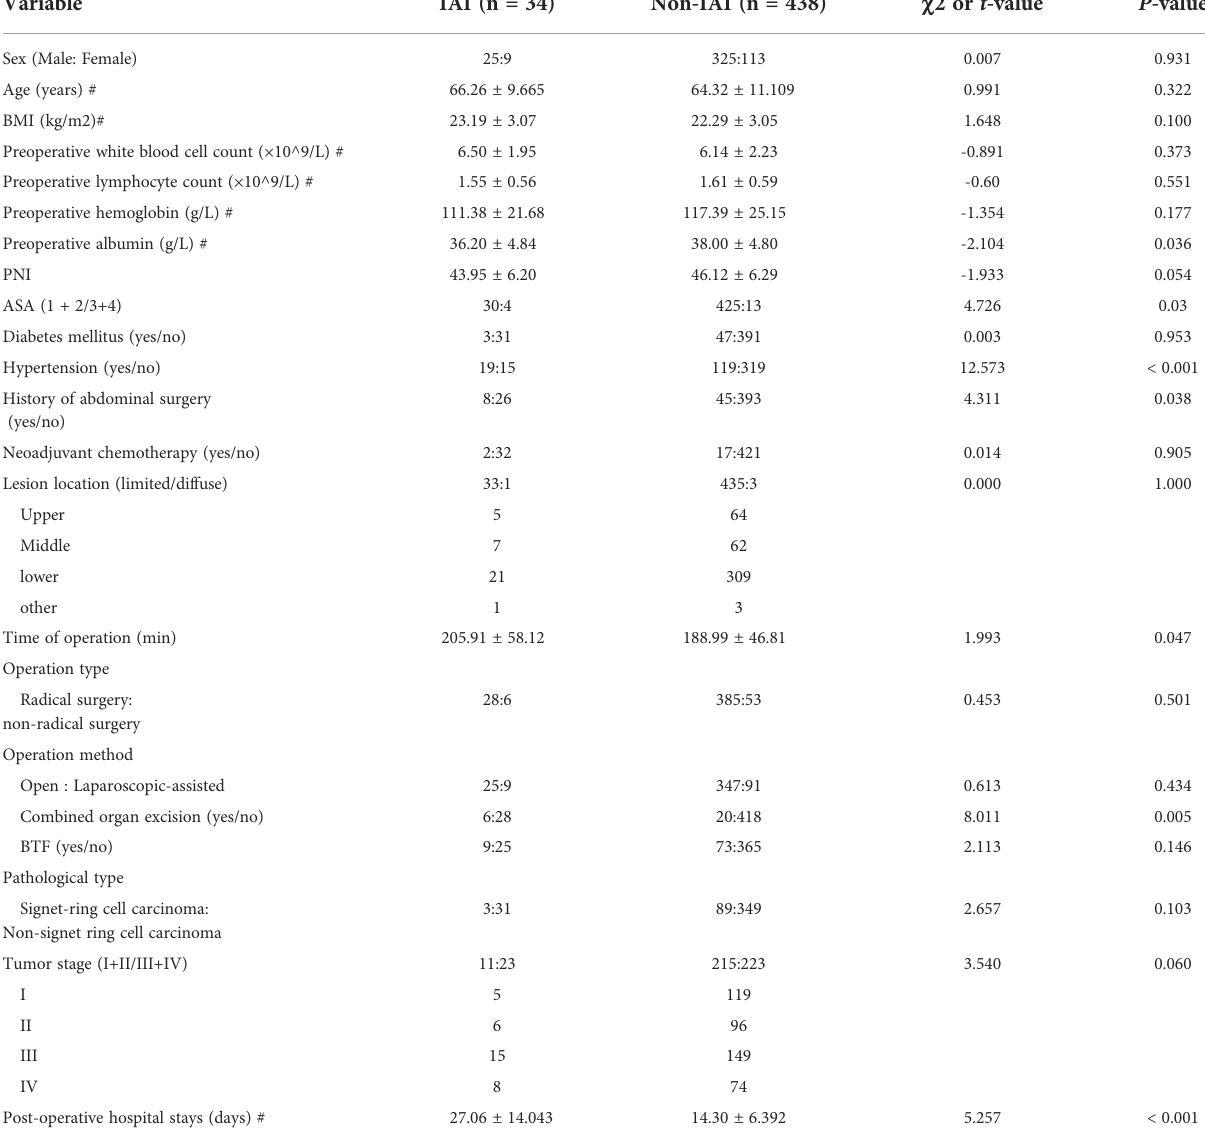
TABLE 1 Clinicopathological characteristics of the patients in training data (n =